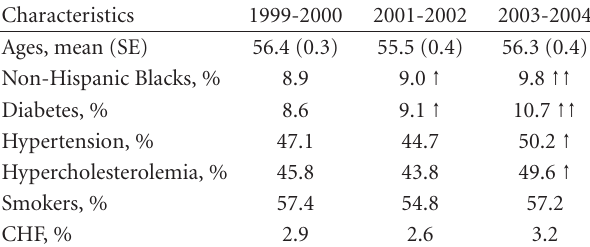
Table 4: Weighted prevalence of risk factors from 1999 to 2004 in the NHANES